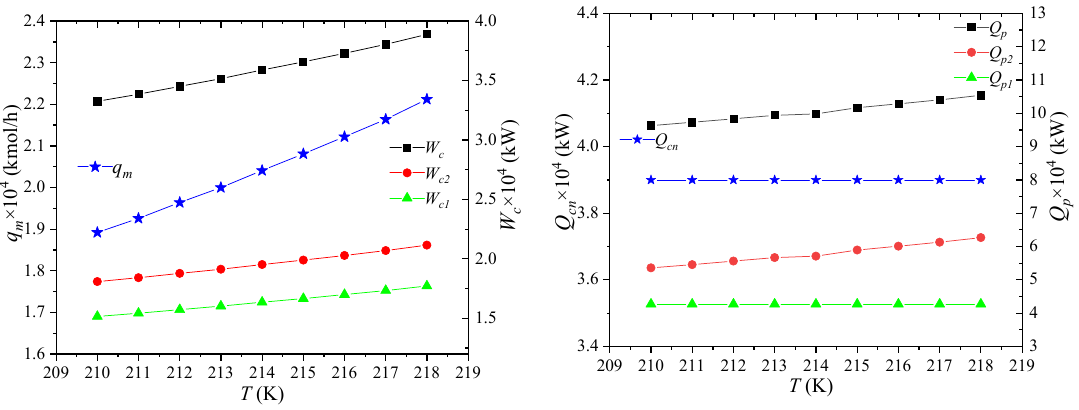
Figure 11. E ff ects of high-pressure mixed refrigerant pressure on process performance. Figure 11. Effects of high-pressure mixed refrigerant pressure on process performance.